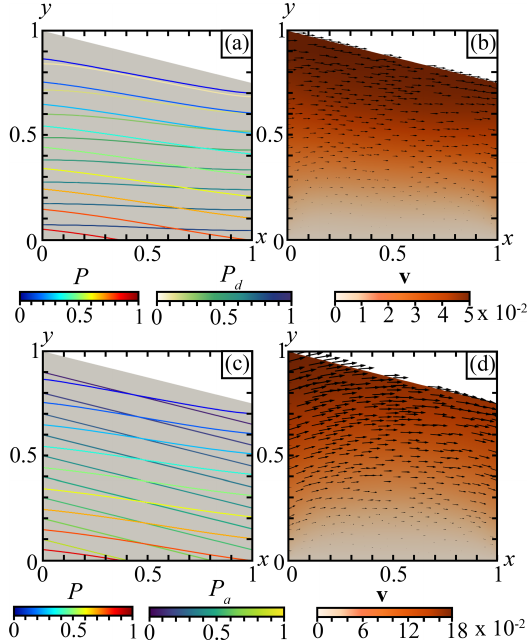
Figure 5. Non-dimensional “regional” model for a small domain with a varying topography. (a) The coloured curves show the total pressure P iso-values computed with Eq. (3) in the global model every 0.1 and the pressure P d computed with Eq. (7) in the re- gional model every 0.1. (b) The coloured background shows the velocity field computed with Eq. (3) with stress boundary condi- tions described by Eq. (33) using P d computed with Eq. (7). The black arrows show the velocity vectors. (c) The coloured curves show the total pressure P iso-values computed with Eq. (3) in the global model every 0.1 and the pressure P a computed with Eq. (2) in the regional model every 0.1. (d) The coloured background shows the velocity field computed with Eq. (3) with stress boundary con- ditions described by Eq. (33) using P a computed with Eq. (2). The black arrows show the velocity